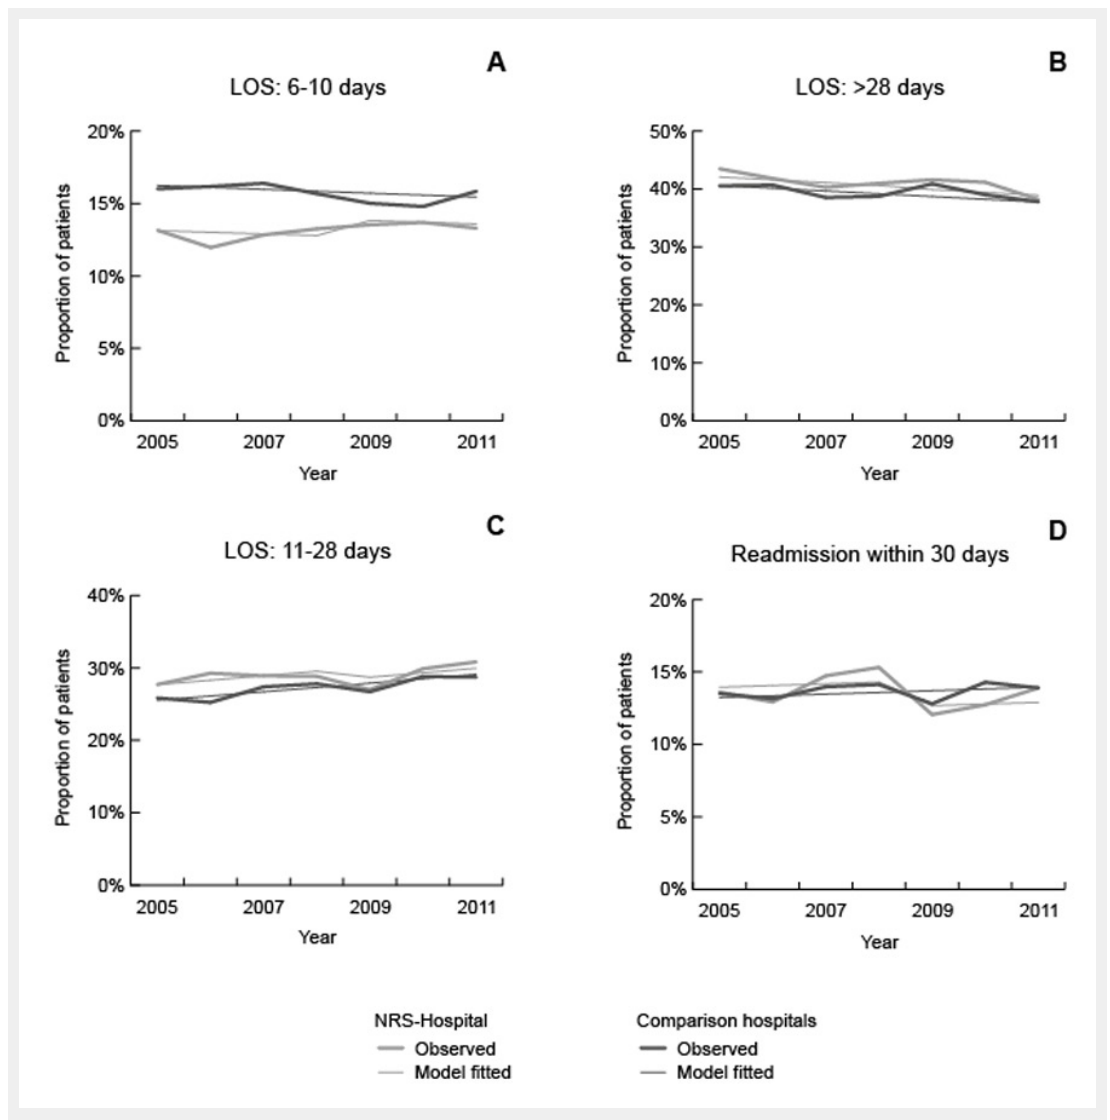
Figure 2 Length of stay-category 6–10 days ( A ), >28 days ( B ), 11–28 days ( C ) and readmission within 30 days ( D ): raw values and estimated values by the General Linear